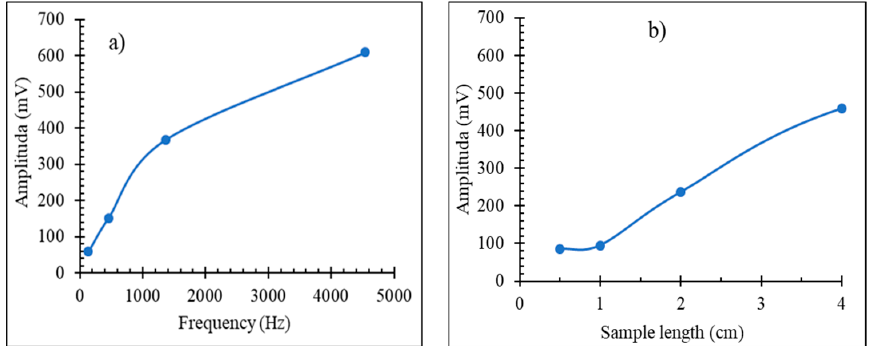
Figure 11. Effect of fundamental frequency of the magnetizing field in ( a ) and sample length in ( b ) on the amplitude of high harmonics (11th harmonic) of glass-coated amorphous Co 71 Fe 5 B 11 Si 10 Cr 3 microwires in the as-prepared state.